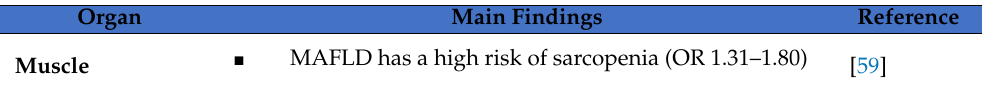
Table 4. Major findings on the relationship between MAFLD and the